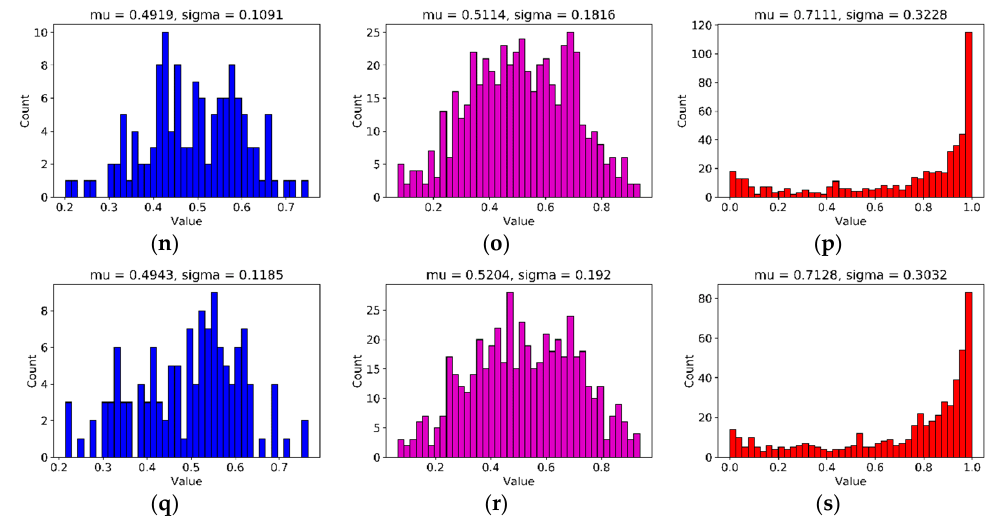
Figure 8. Visualization of each SE block; mu and sigma represent mean and standard deviation. ( a–c ) and ( k–m ) are feature importance distributions for large-size canker (Figure 3a) and large-size southern green stink bug (Figure 3d); ( d–f ) and ( n–p ) are feature importance distributions for middle-size canker (Figure 3b) and middle-size southern green stink bug (Figure 3e); ( h–j ) and ( q–s ) are feature importance distributions for small-size canker (Figure 3c) and small-size southern green stink bug (Figure 3f); ( a ), ( d ), ( h ), ( k ), ( n ), and ( q ) are the output of SE block 1; ( b ), ( e ), ( i ), ( l ), ( o ), and ( r ) are the output of SE Table 2. Statistics for different levels of features.